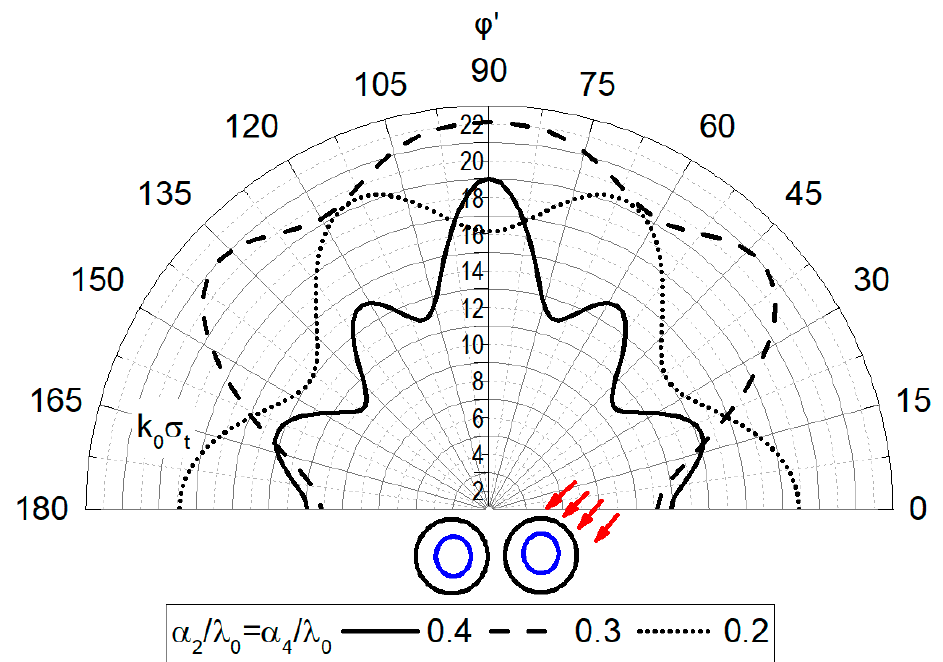
′ φ σ ) versus for the inset structure, = 0.2 λ = 0, 0 , 0.3 λ 0 , 0.4 λ 0 , while E 0 4